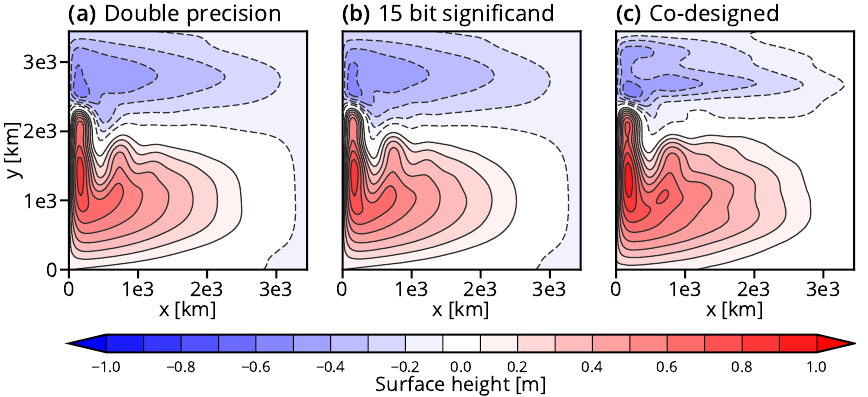
Figure 5. Time-mean surface height field for simulations of the shallow-water model calculated over 15 million time steps. (a) Double- precision reference simulation, (b) reduced precision with 15bit significand for all floating-point numbers, and (c) simulation co-designed for half precision.